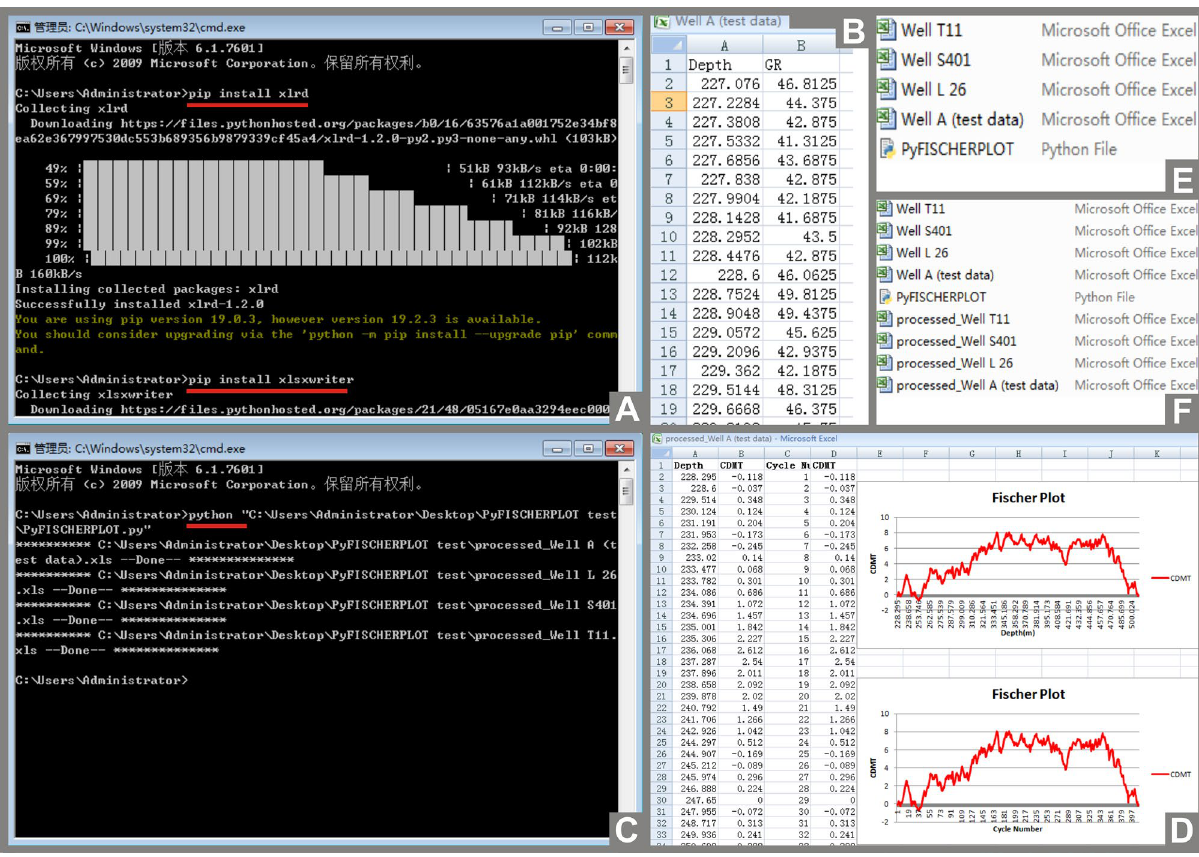
Figure 3. Demonstration of steps of using PyFISCHERPLOT.py file. Entering pip install xlrd and pip install xlsxwriter in the command prompt window to install Python libraries ( A ). Placing the PyFISCHERPLOT. py file and the Excel files which contain natural gamma-ray data of each well (Well A, Well T11, Well S401, Well L26) in the same path (folder) ( B ), ( E ). Typing in python and pressing the Space key, then dragging the PyFISCHERPLOT.py file onto command prompt window to run the PyFISCHERPLOT.py file ( C ). New Excel files containing the Fisher plot of each well in both the time (i.e. cycle number) and depth domains are established by PyFISCHERPLOT code in the same path ( D ), ( F